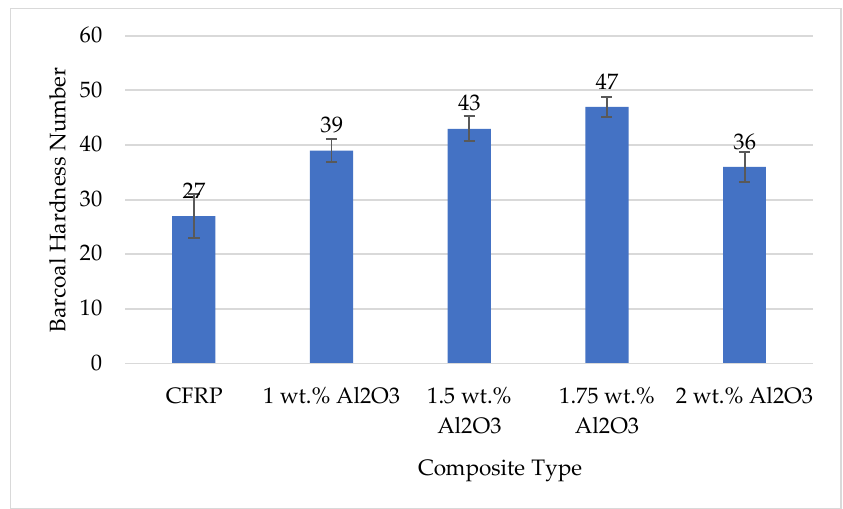
Figure 13. Barcol hardness number of CFRP and Al 2 O 3 hybrid nano-composites.